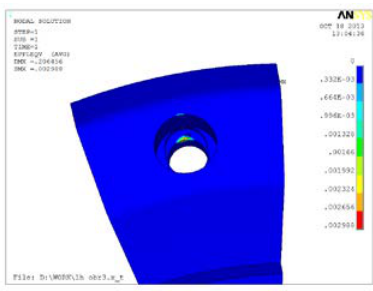
Fig. 12. Equivalent plastic deformation